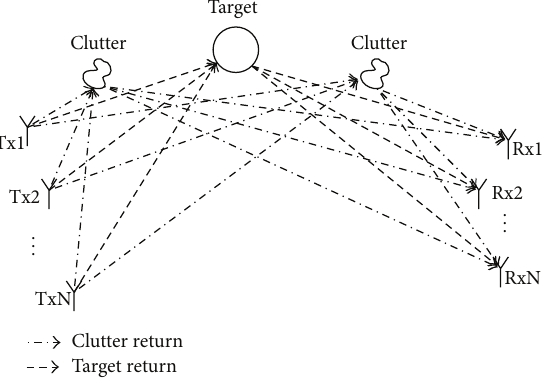
Figure 1: System model for a bistatic MIMO